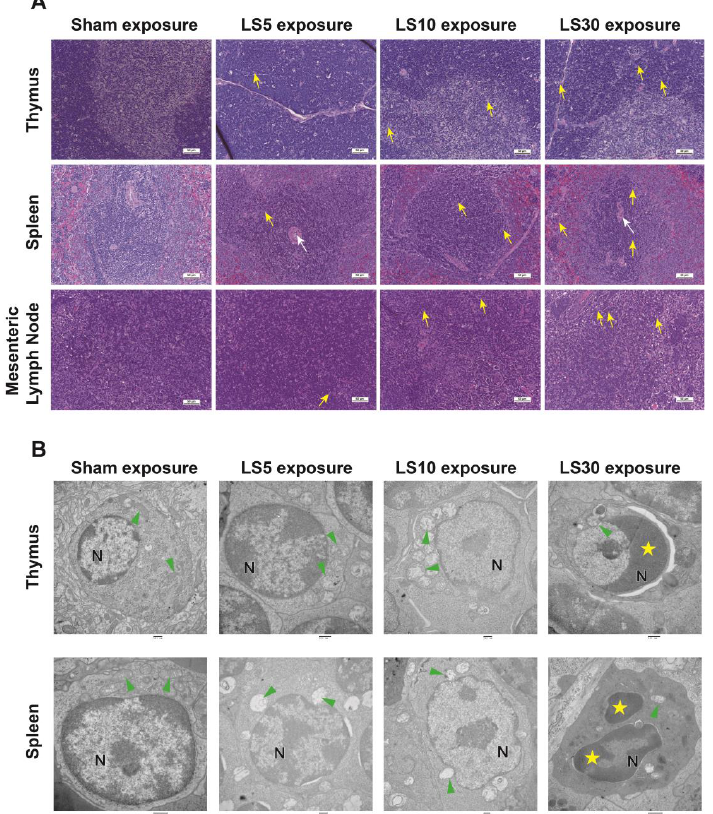
Figure 1. Structural injuries of the thymus, spleen, and mesenteric lymph nodes at 7 d after exposure to multifrequency microwaves. Male Wistar rats were sequentially exposed to 1.5 GHz and 2.8 GHz microwaves at average power densities of 5 (LS5), 10 (LS10), and 30 (LS30) mW/cm 2 as described in the Materials and Methods. Representative photomicrographs of the thymus, spleen, and mesenteric lymph nodes ( A ) and representative electron micrographs of the thymus and spleen ( B ) at 7 d after exposure. The yellow arrows indicate lymphocyte nuclear fragmentation, and the white arrows indicate tissue sinus congestion in Figure 1A ( Scale bar = 50 μm ). The letter N represents the nucleus of the cell, the green triangle indicates the mitochondria in the cell, and the yellow pentagon indicates the nucleus fragment in Figure 1B (Scale bar = 500 nm).